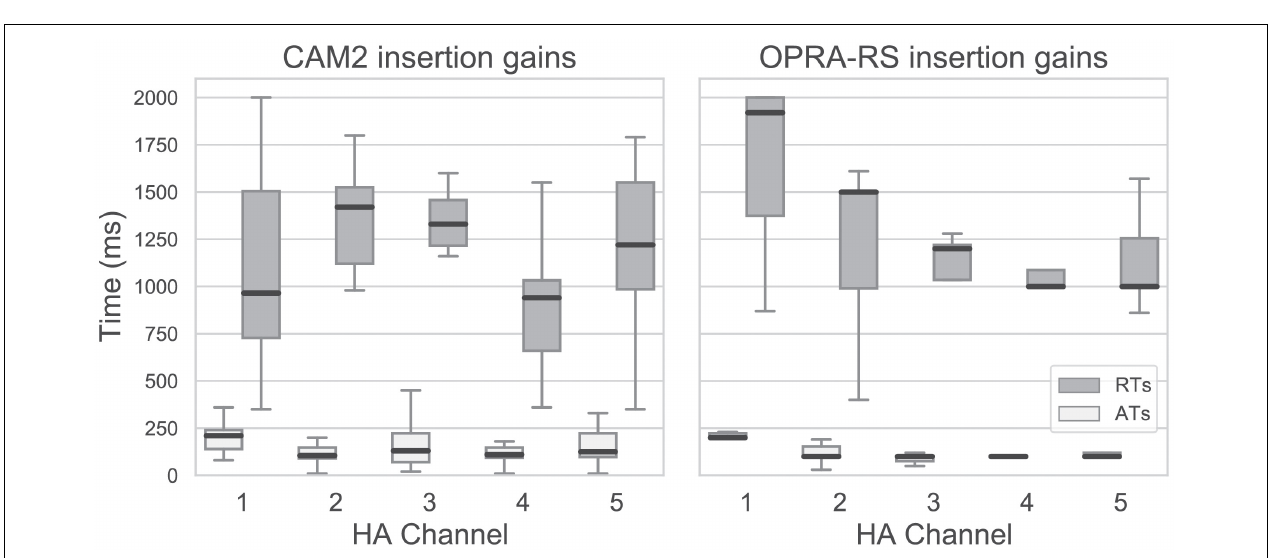
FIGURE 3 | ASR scores with or without optimization of time constants, using the insertion gains recommended by CAM2 (left panel) or OPRA-RS (right panel) for the 12 audiograms. Horizontal, thick dark lines inside the boxes represent median values. The 0 and 100th percentiles are represented by the bottom and top whiskers, while the bottom and top limits of the boxes represent the 25th and 75th percentiles.